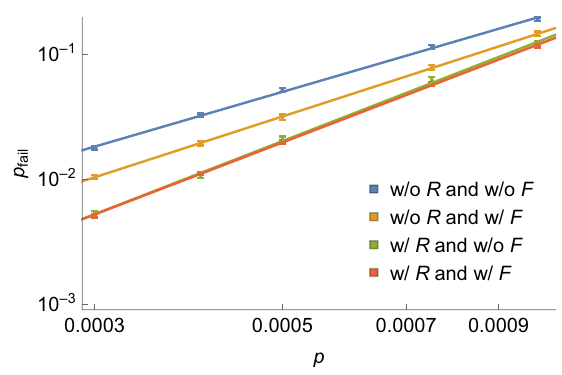
FIG. 39. Overall code-switching performance of four syn- drome fixing approaches for the preparation of 2D spherical color codes. Each approach either uses or does not use the repeat ( R ) and flip ( F ) strategies for distance d = 9. In the approach, which uses both strategies, we use the repeat strategy, and the flip strat- egy if the repeat also yields an invalid syndrome. In each case, the stabilizers are measured with the CNOT circuits described in Table V. Both the repeat and flip strategies improve